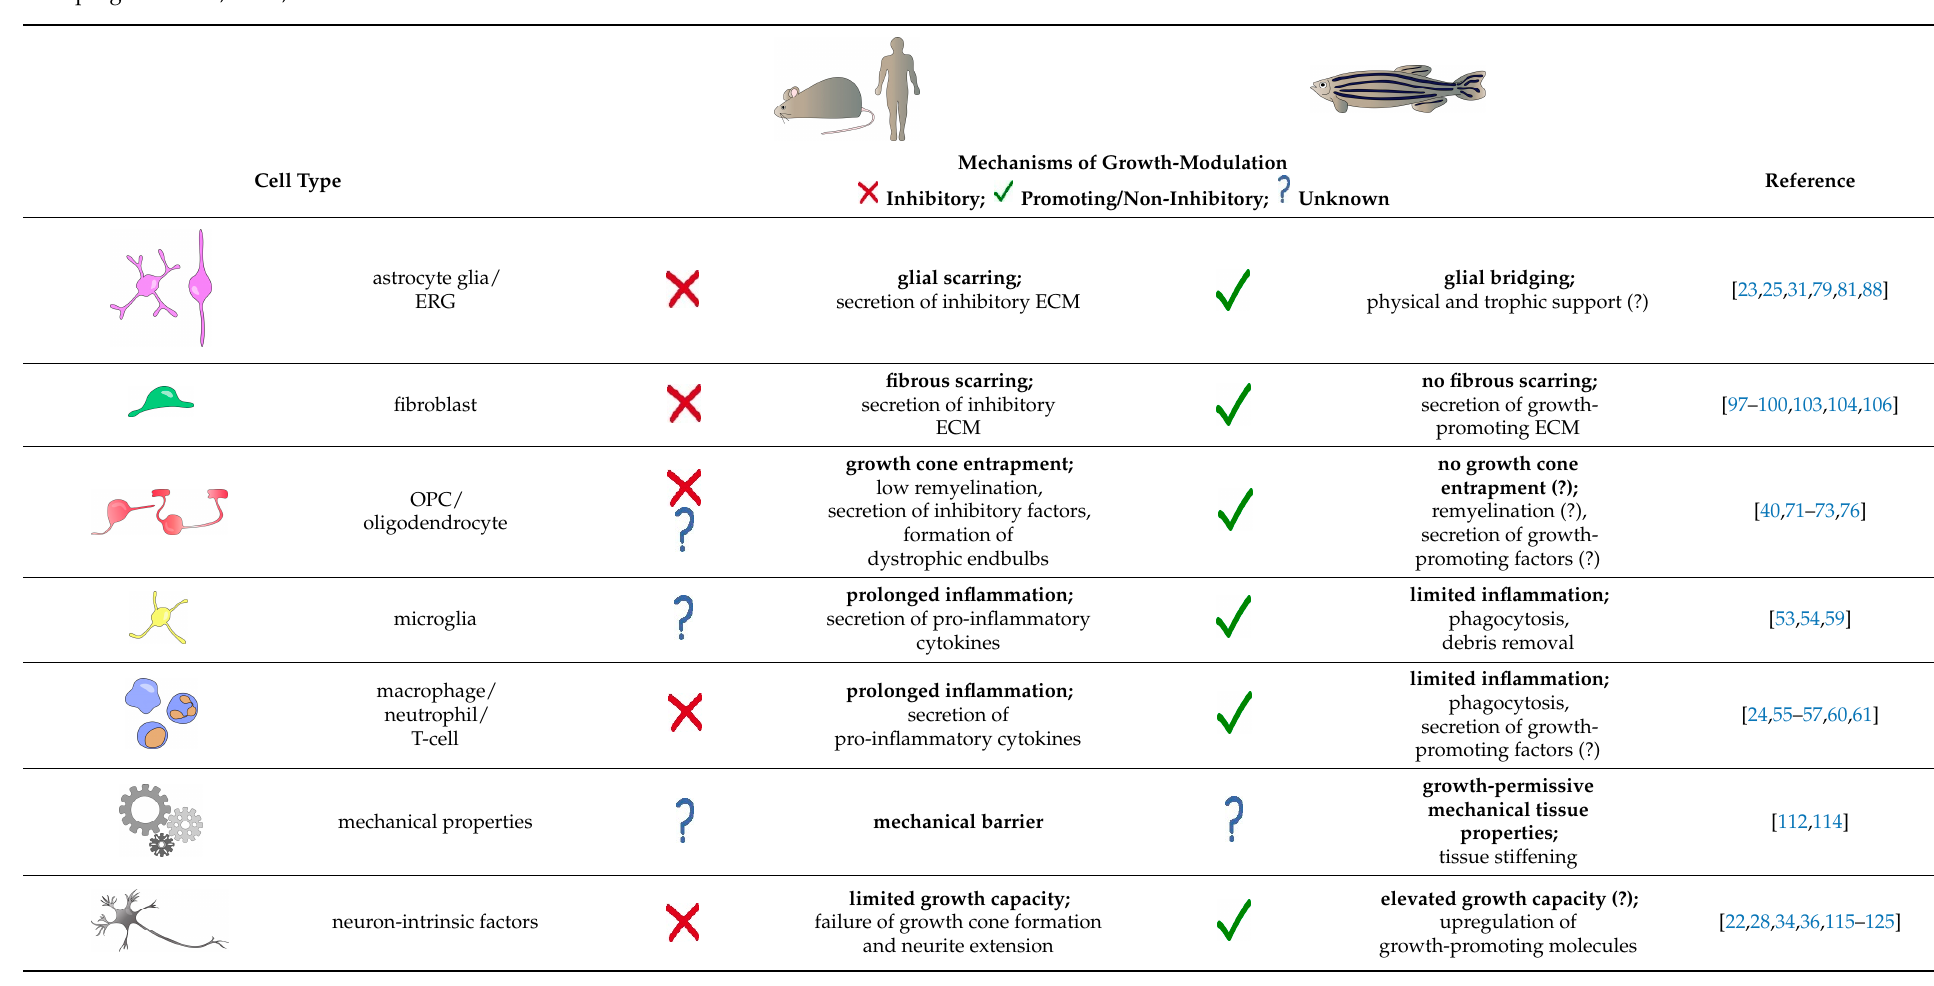
Table 1. Growth-promoting or limiting contributions of different cells types to axon regeneration in mammals and zebrafish. (X) indicates inhibitory and ( ✓ ) promoting or non-inhibitory effect of the indicated cell type on axon regeneration. (?) indicates that the mechanism of action remains to be shown. Abbreviations: ERG, ependymo-radial glia; OPC, oligodendrocyte progenitor cell; ECM, extracellular matrix.